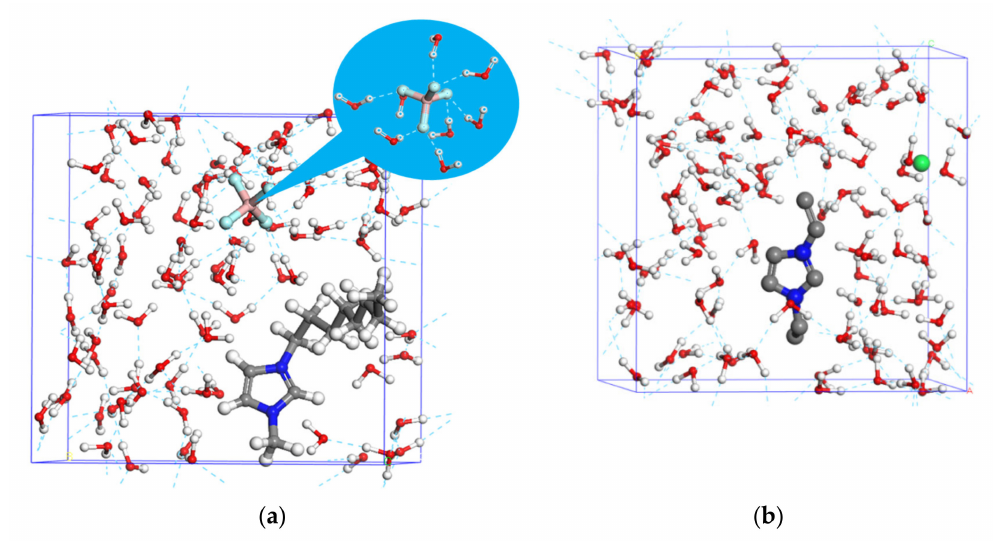
Figure 4. Interaction between different kinds of ILs and water molecules:( a ) C 8 -OMImBF 4 ; ( b ) C 2 -VEImBr).